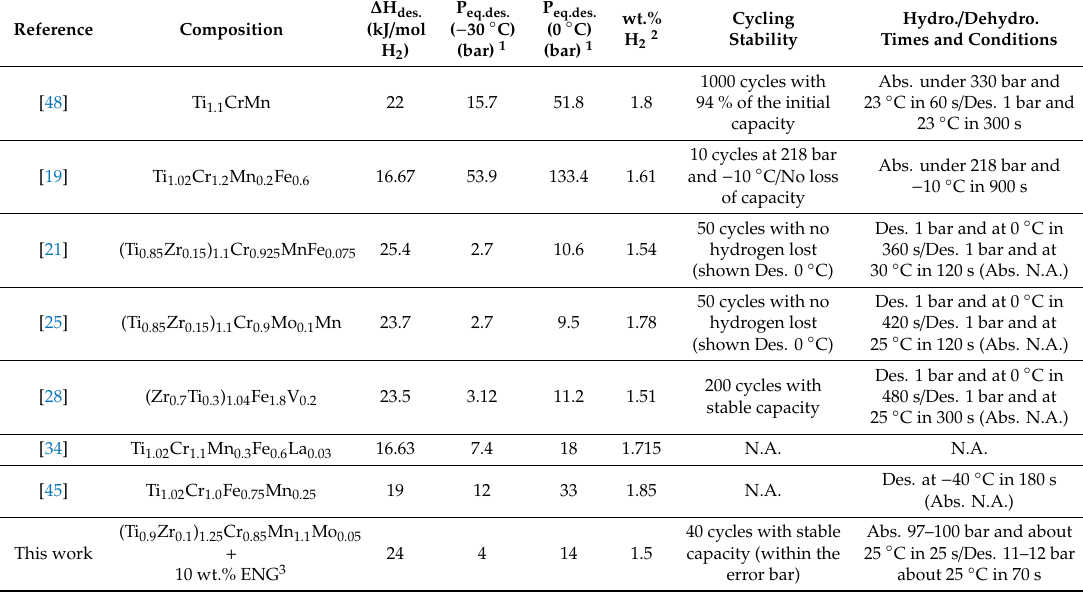
Table 1. Comparison of the main hydrogen storage properties among materials developed for the hybrid